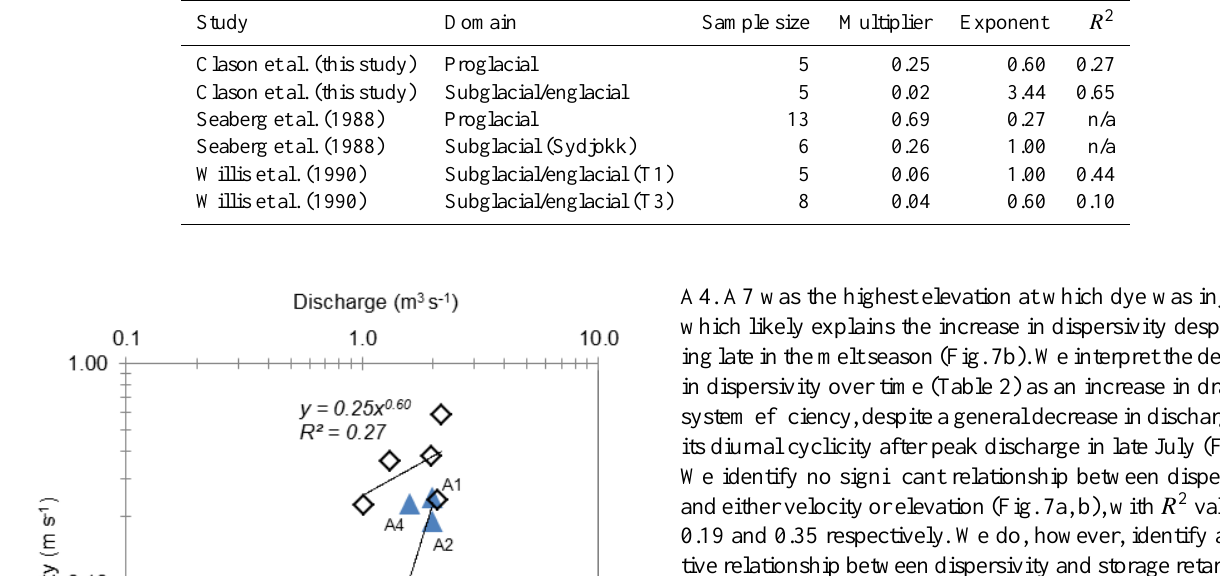
Table 3. Velocity–discharge analyses from Rabots glaciär, Sweden (this study), Storglaciären, Sweden (Seaberg et al. 1988) and Midtdals- breen, Norway (Willis et al. 1990). Note that experiments were conducted over a period of 2 years for both Storglaciären and Midtdalsbreen.